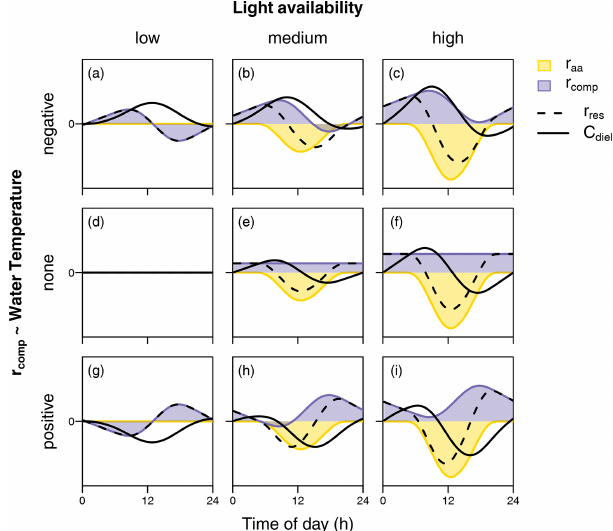
Figure 7. Schematic representation of diel courses of assimilation rate ( r aa ) and a complementary processing rate ( r comp ) required to produce equilibrium conditions. Black lines show the resulting change rate ( r res ) and concentration ( C ). While r aa is considered a function of global irradiance (columns represent different lev- els of irradiation intensity), r comp is conceptualized as a function of stream temperature (rows represent a negative, a–c ; no relation- ship, d–f ; and a positive relationship, g–i